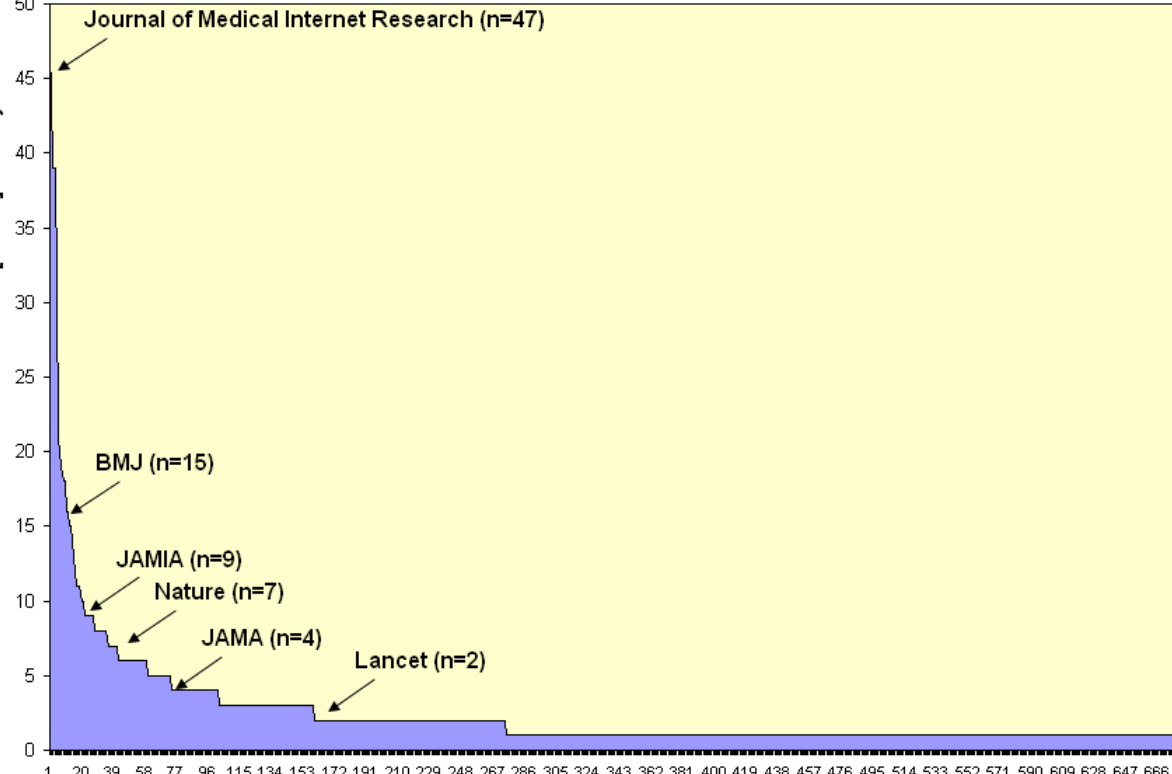
Figure 1. Information scatter in eHealth: Distribution of “Internet”-related papers published in 2003/2004 by journal (with some prominent journals highlighted). While the Journal of Medical Internet Research attracts more pertinent papers in this field than any other journal, the majority of